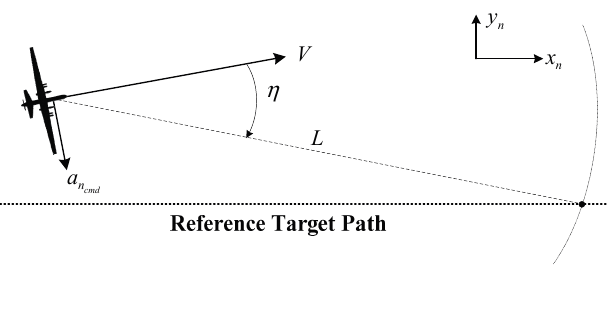
Figure 9. Nonlinear path-following guidance.